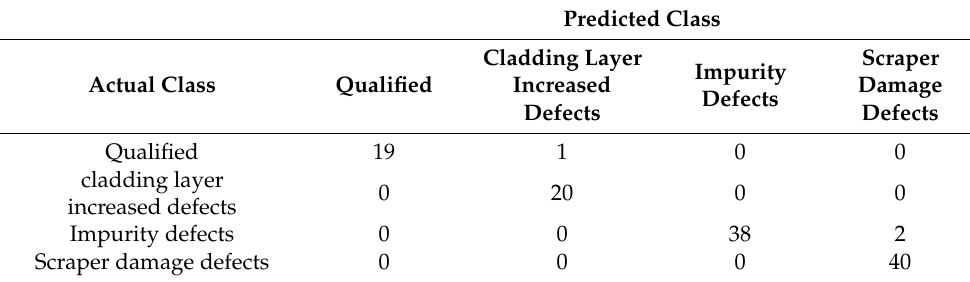
Table 2. The confusion matrix of the SVM classification